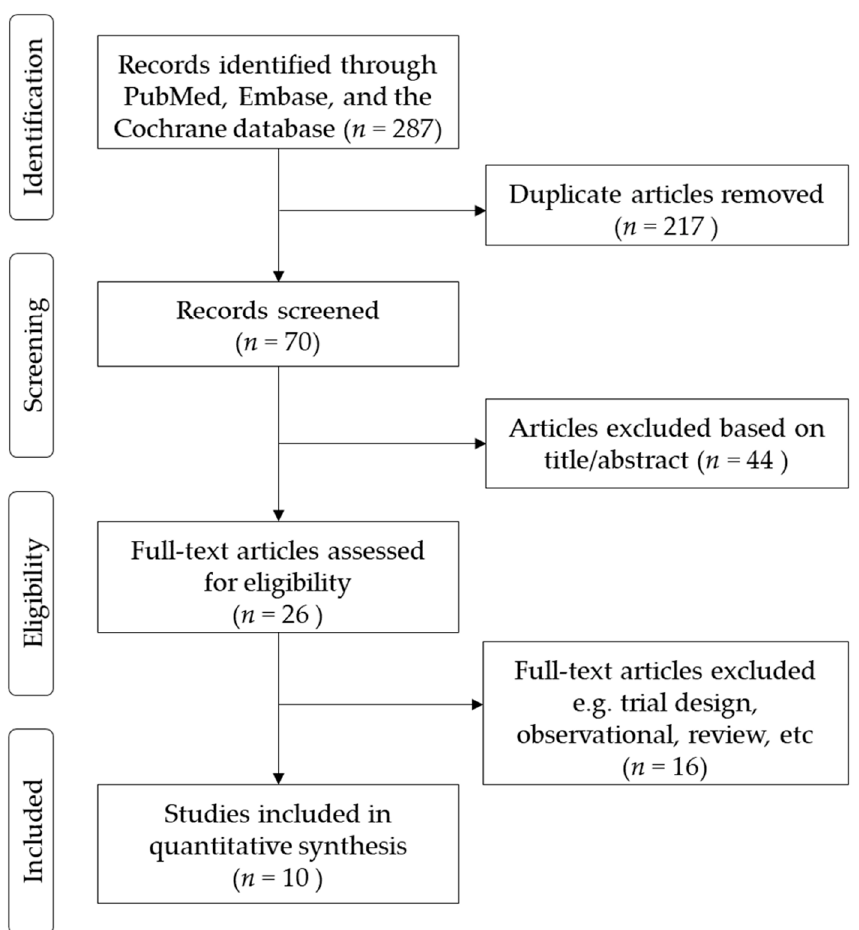
Figure 1. Flow diagram of included studies.